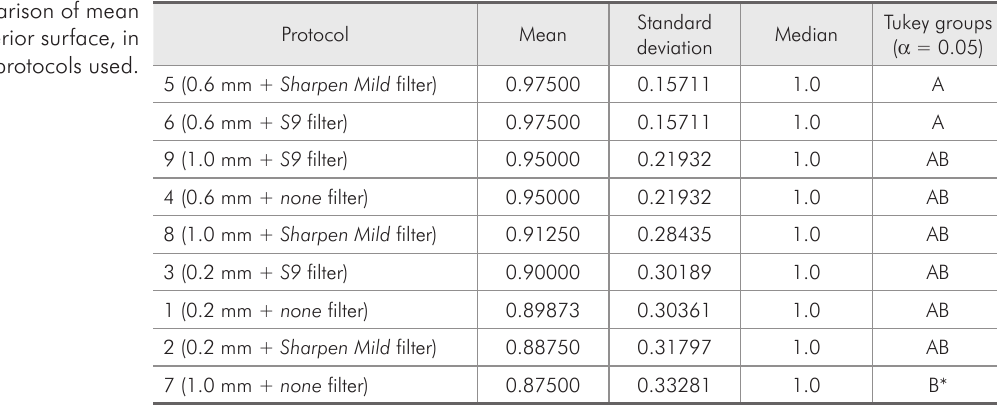
Table 5 - Comparison of mean hits on the posterior surface, in each of the nine protocols